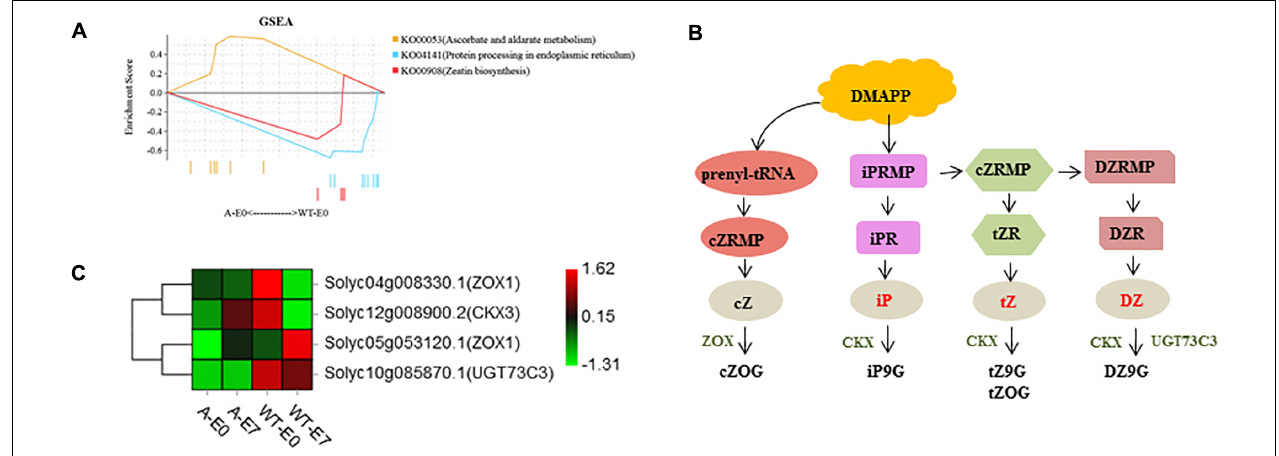
FIGURE 7 | Functional analysis of DEGs specifically expressed in SlTPL1RNAi tomato ovaries at E0 stage. (A) Significantly enriched gene sets of DEGs in ovaries of emasculated flowers between WT and SlTPL1-RNAi plants at E0 stage; (B–C) Zeatin biosynthesis pathway and heatmap of DEGs in the gene set of Zeatin biosynthesis.